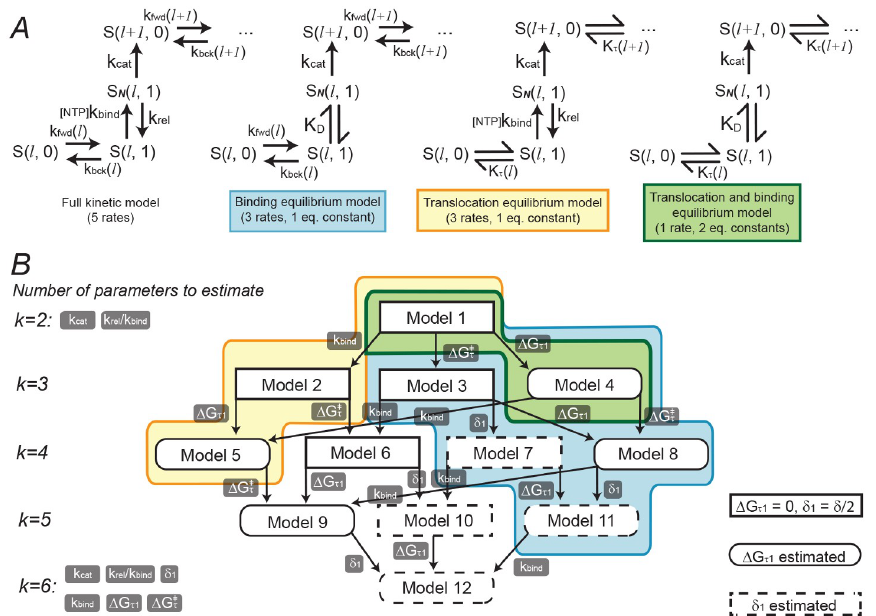
Fig 4. The space of models to be compared. (A) The four equilibrium model variants. NTP binding, translocation, both, or neither, could be assumed to achieve equilibrium prior to catalysis. (B) The 12 transcription elongation models. An arrow connects model i to j if augmentation of model i with a single parameter generates model j . The number of parameters to estimate k is shown for each level in the network. Equilibrium approximation colour scheme is the same as in A. Δ G and δ 1 can each be estimated or set to a constant. τ 1